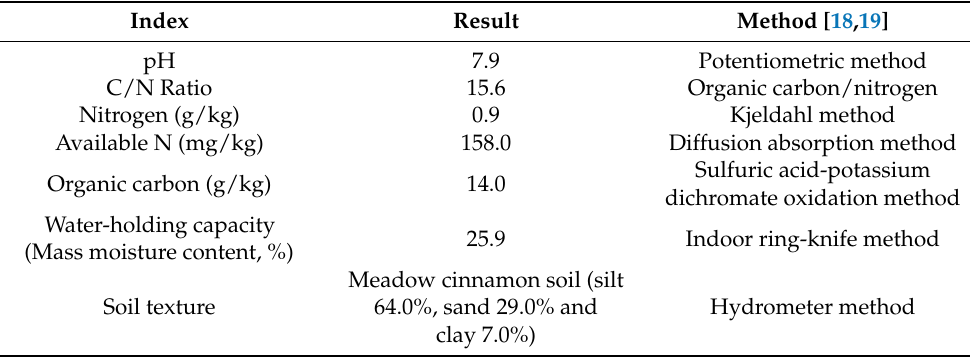
Table 2. Soil properties and test methods of related